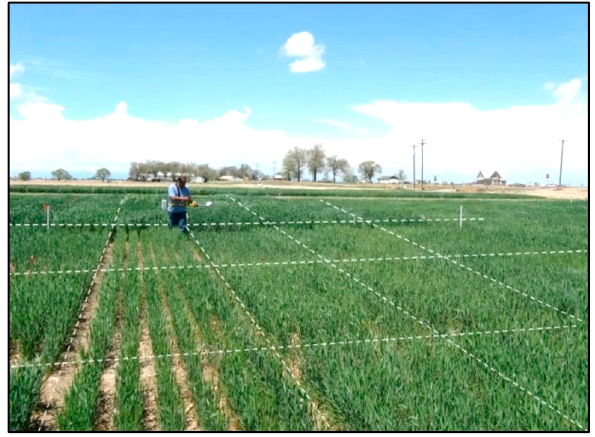
Figure 1. The normalized difference vegetation index (NDVI) readings were collecting using a Greenseeker ® handheld optical sensor. Plot boundaries are highlighted with white dashed lines.